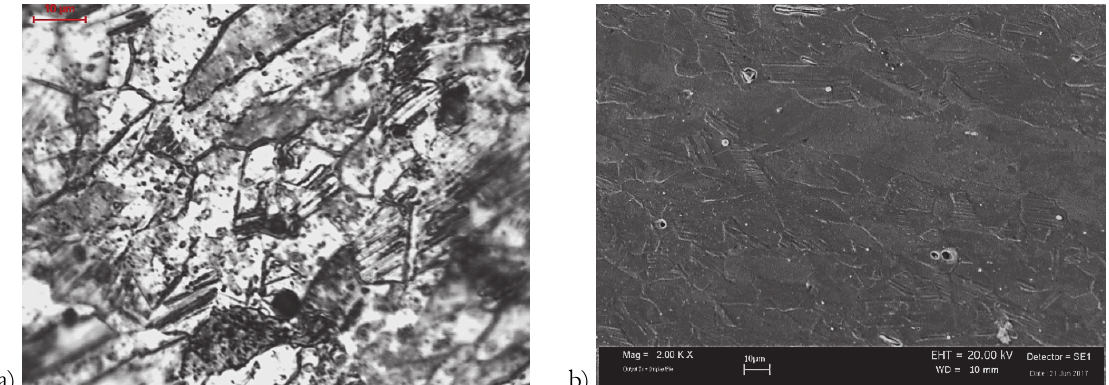
Figure 13: Glyceregia etched as received steel: a) Optical and b) SEM